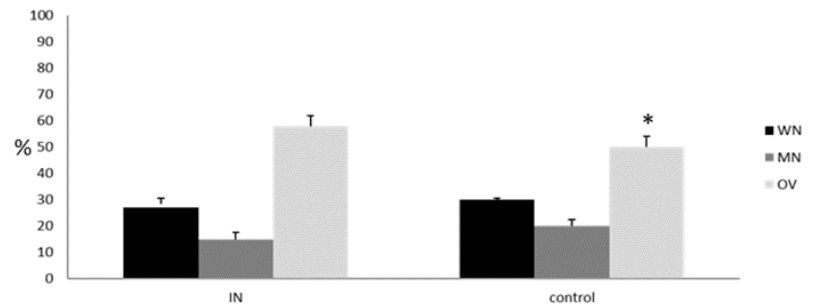
Figure 1. Nutritional status according to MNA test and BIVA assessment in IN and control group; WN: well-nourished; MN: malnourished; OV: overweight; * p < 0.05.